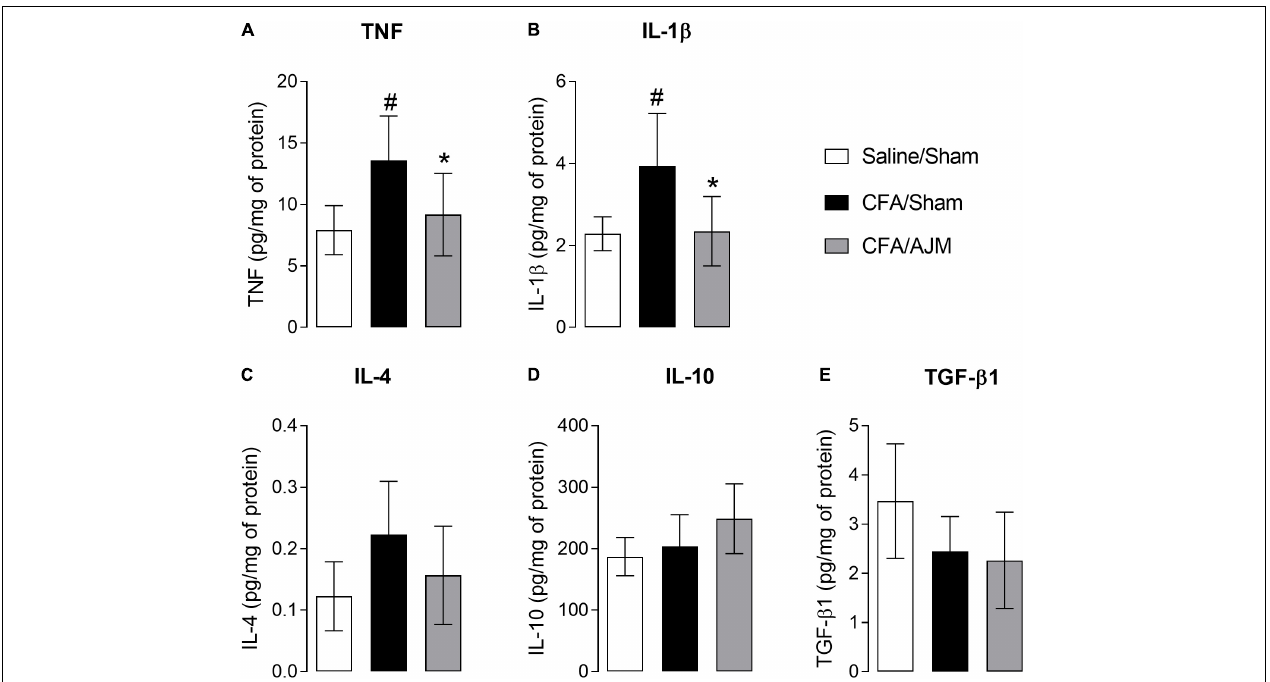
FIGURE 5 | Effects of AJM on the concentrations of pro-inflammatory IL-1 β (A) and TNF (B) , and anti-inflammatory IL-4 (C) , IL-10 (D) and TGF- β 1 (E) cytokines in the spinal cord of Swiss male mice 98 h after intraplantar CFA-induced inflammation. Data are expressed as mean ± SD of 7 animals per group, statistically assessed by one-way ANOVA followed by Tukey’s post hoc test. # p < 0.05 when compared to the Saline/Sham group. * p < 0.05, when compared to the CFA/Sham group. CFA, Complete Freund’s Adjuvant; AJM, Ankle Joint